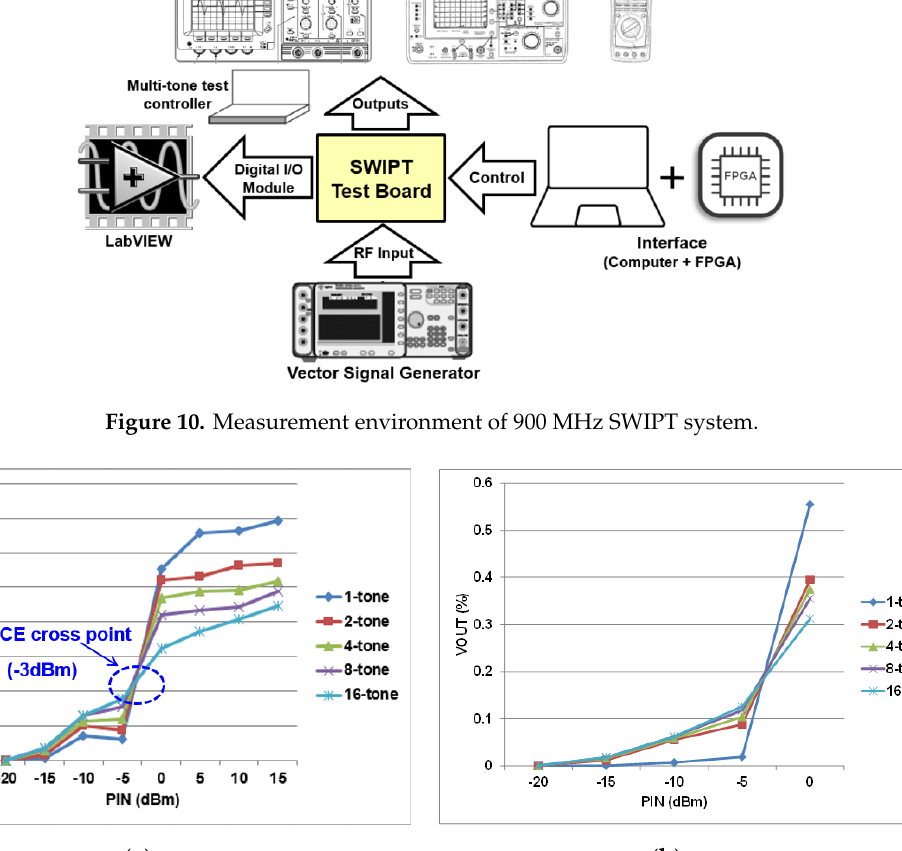
Figure 11. Measured performance of a single-stage radio frequency–direct current (RF–DC) converter. ( a ) Power conversion e ffi ciency (PCE) versus input power P IN with respect to number of tones; ( b ) output voltage versus input power P IN with respect to number of tones.